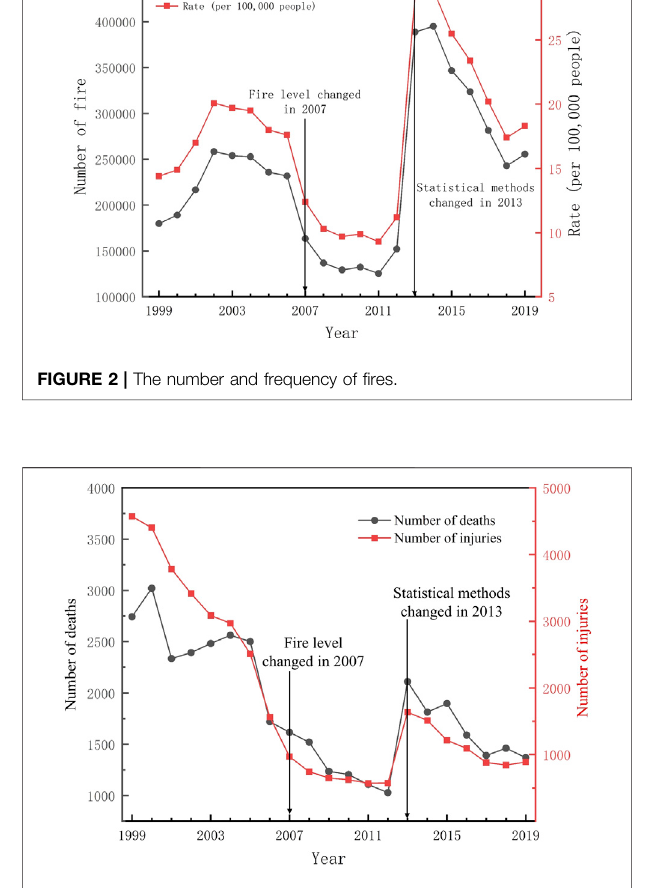
FIGURE 3 | The number of deaths and injuries.